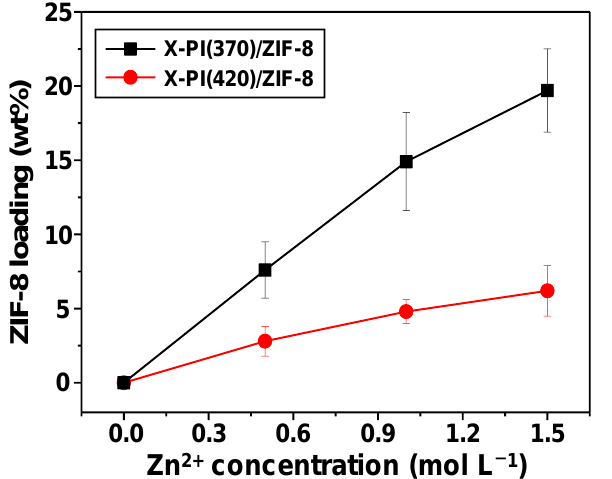
Figure 6. ZIF-8 loadings in X-PI/ZIF-8 MMMs as a function of the zinc concentrations of the ion exchange solutions.